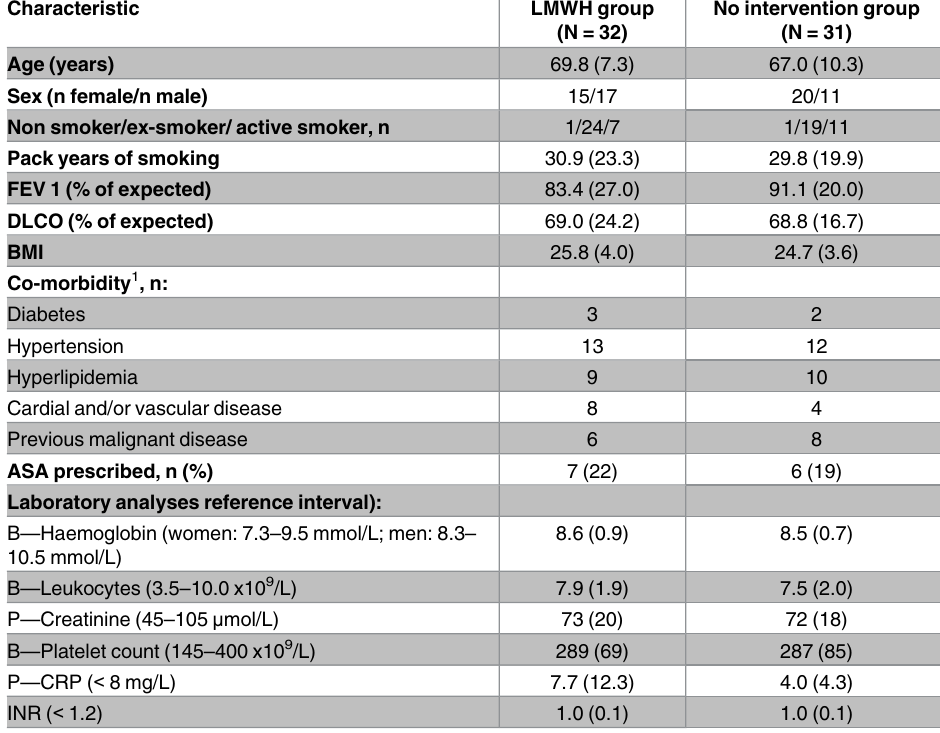
Table 1. Baseline data (preoperative) from 63 patients planned for Video-Assisted Thoracoscopic Surgery (VATS) lobectomy for primary lung cancer.